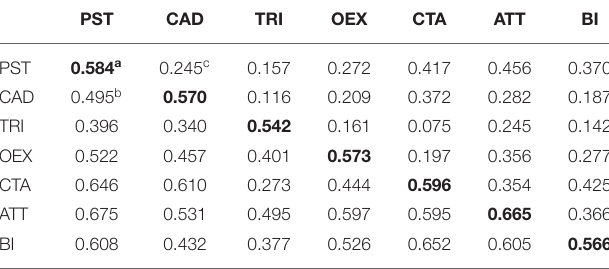
TABLE 4 | AVE, correlations, and squared correlations of the constructs.